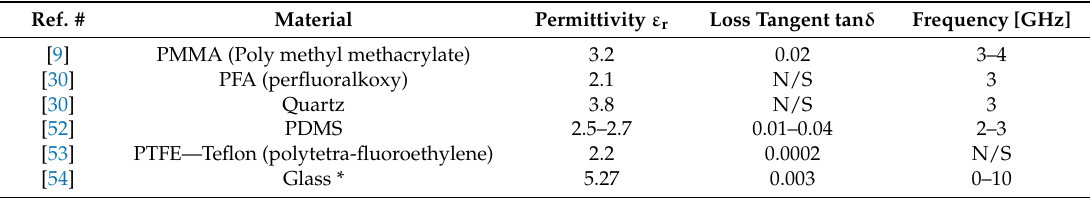
Table 1. Dielectric properties of commonly used materials to realize microfluidic channels in sensing devices.